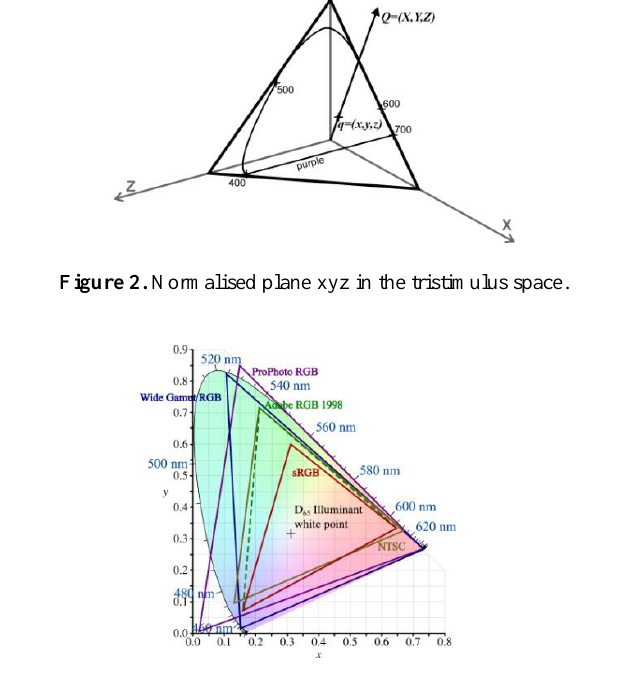
Figure 3. Comparison between gamuts of several colour spaces and CIE 1931 Chromaticity